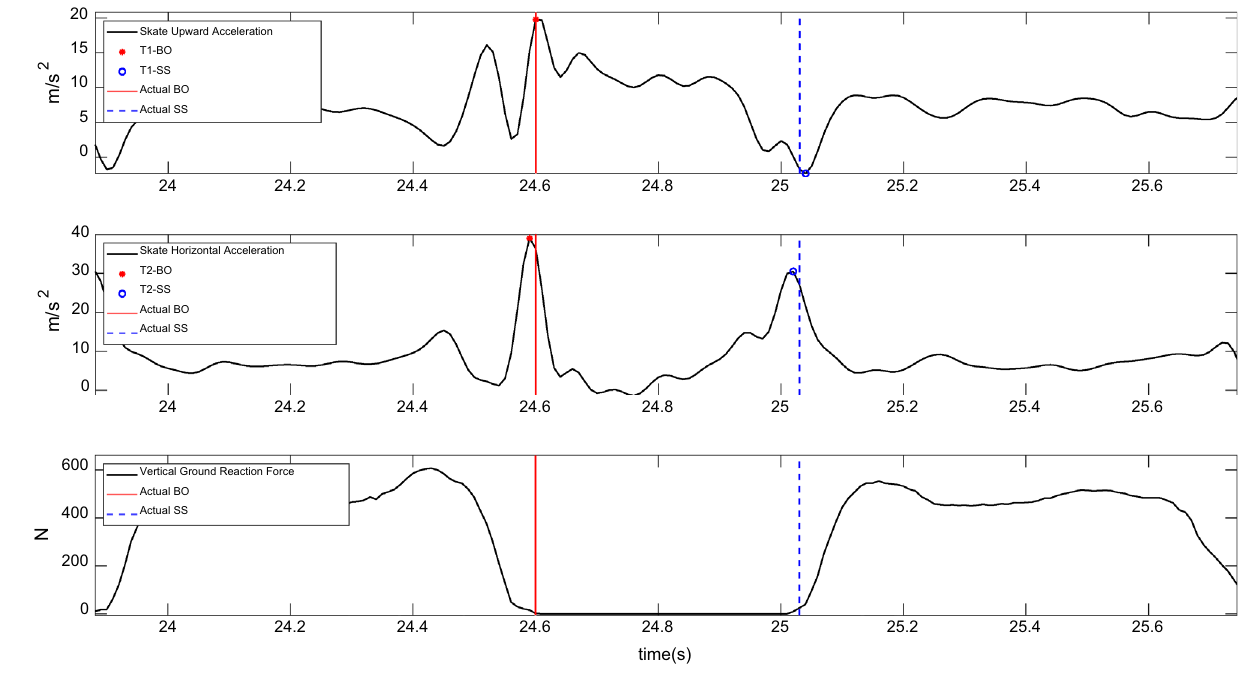
Figure 2. Exemplar recorded time series of skate upward and horizontal acceleration measured by the skate- mounted IMU in a skating trial. The figure also shows the temporal events (SS: skate strike and BO: blade off) detected by algorithms T1 and T2 and the actual events detected using the pressure insoles (gold-standard), based on a 5-N threshold on the vertical ground reaction force. Actual SS and BO were obtained from the first data points after the vertical ground reaction force passed the 5-N